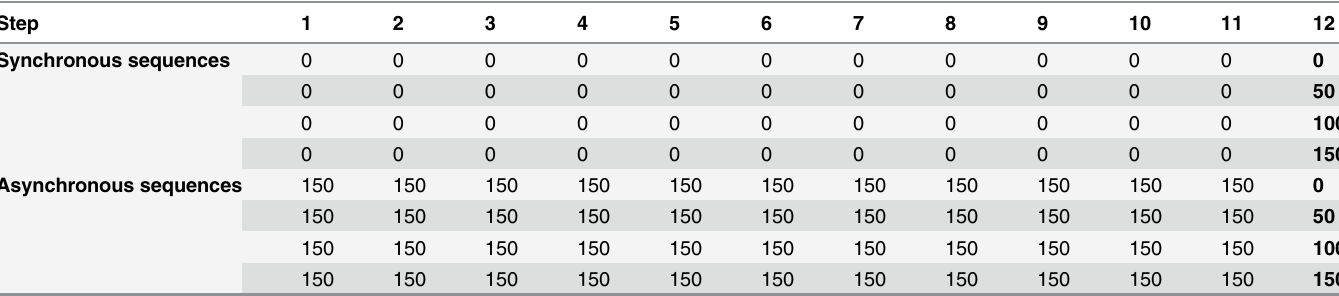
Table 2. Sequences of AV intervalsin Experiment 2 and 4: 0 and 150 ms constant interval conditions. Step